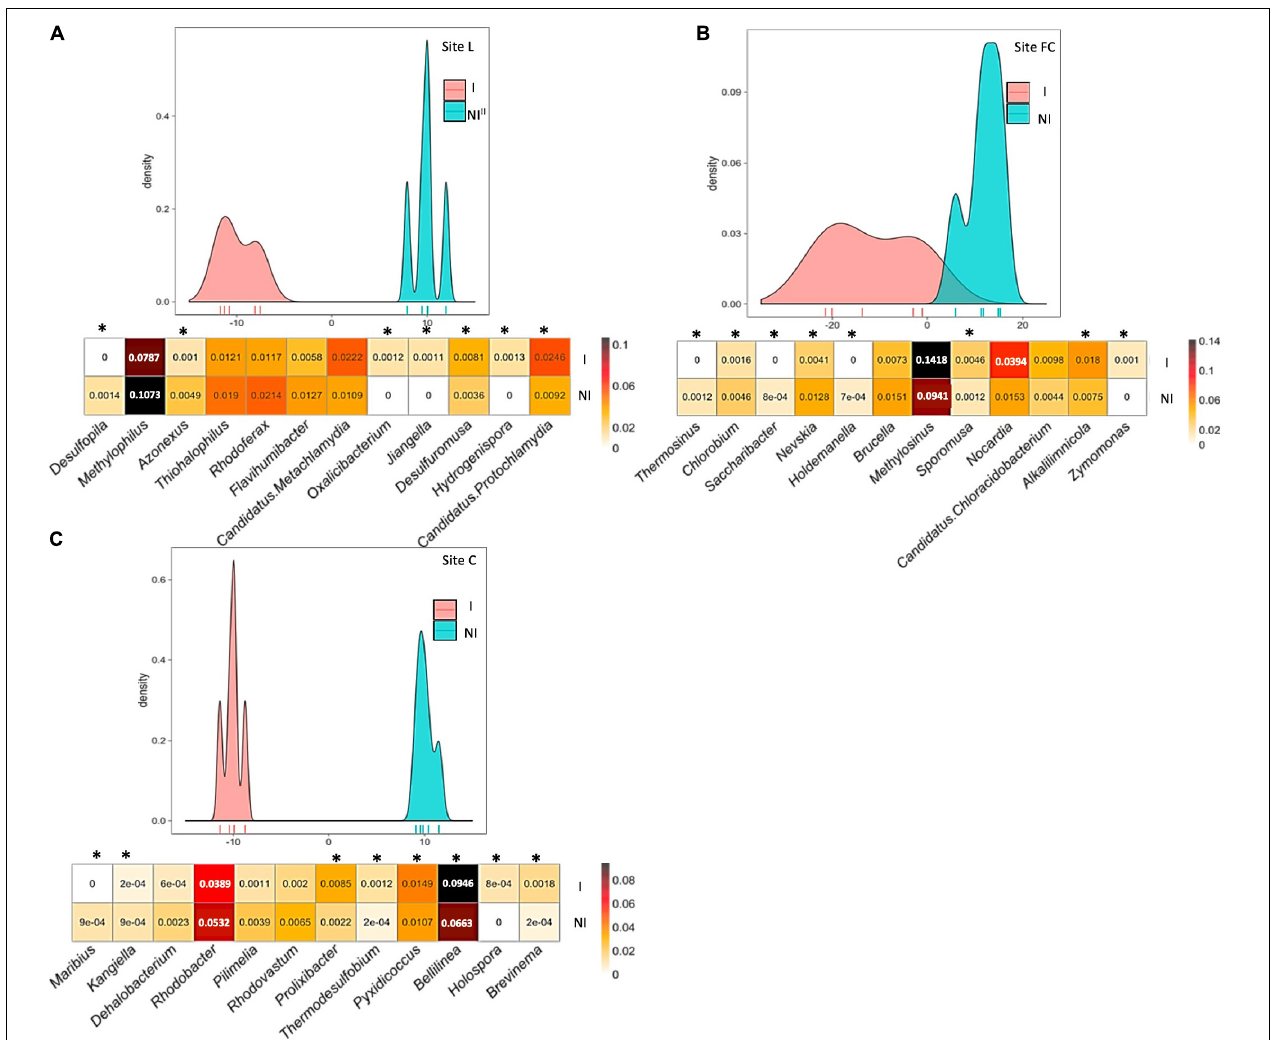
FIGURE 4 | Between-class analysis of the effect of seed inoculation with A. lipoferum CRT1 on the composition of the total bacterial community in the maize rhizosphere at the six-leaf stage at three field sites L (A) , FC (B) , and C (C) , in 2015. NI and I correspond, respectively, to non-inoculated and inoculated conditions. For each site, the BCA graph is completed (below) by the distribution of the bacterial OTUs according to their contribution to treatment differentiation; BCA is statistically supported by a Monte Carlo test at sites L ( p = 0.005), FC ( p = 0.006), and C ( p = 0.005), and the heatmap below indicates the relative proportions for the 12 bacterial genera most impacted by inoculation in maize rhizosphere. Six bacterial genera most commonly associated with inoculation are indicated at the left, as well as six bacterial genera most often associated with the non-inoculated control (right). Statistical differences between inoculated and non-inoculated treatments are indicated by stars ( ∗ ) (Wilcoxon test, p < 0.05). Heatmap unit is a percentage of the average relative proportion of